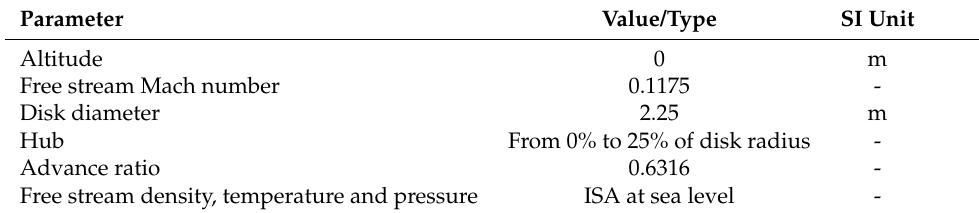
Table 2. Reference data for the isolated disk test case.